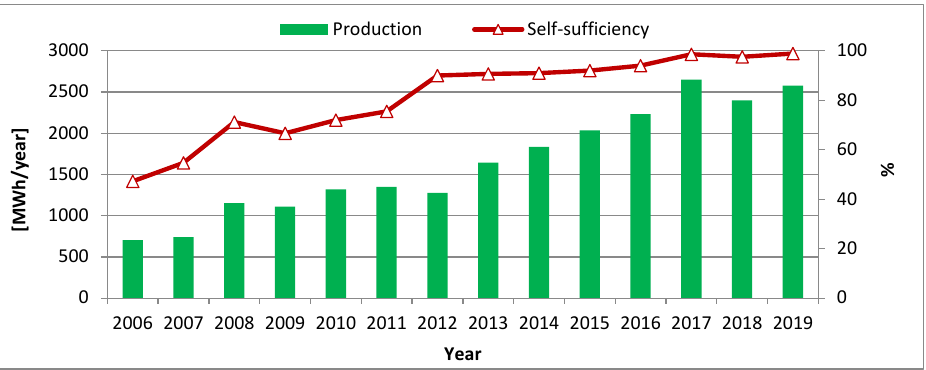
Figure 13. Energy balance at the Iława WWTP.